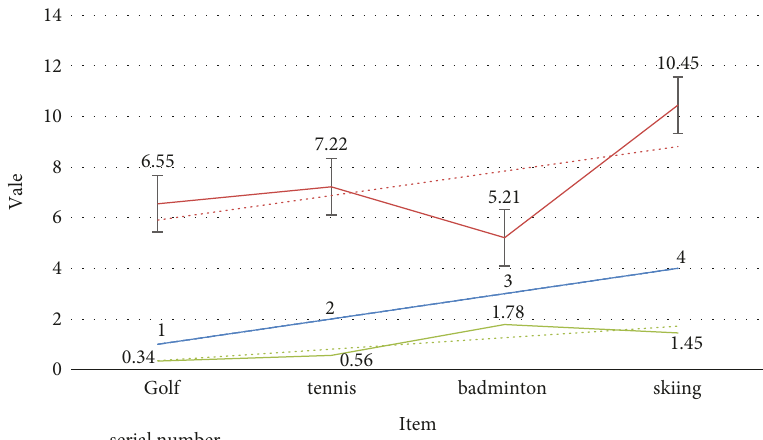
Figure 6: Graphene equipment